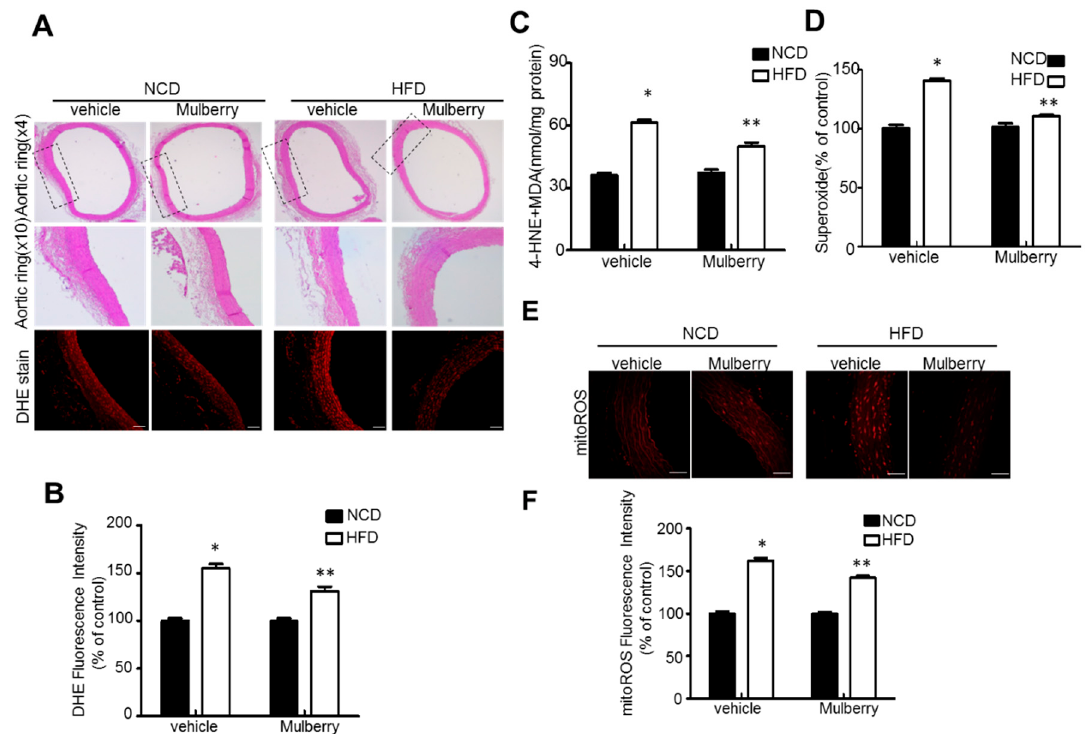
Figure 3. Mulberry inhibits oxidative stress in hyperlipidemic rats. Rats were fed a normal diet or a high-fat diet with or without 100 mg / kg mulberry for six weeks, and serum and aorta rings were harvested. ( A ) Aorta rings tissues retrieved six weeks after initial mulberry administration were subjected to hematoxyline-eosine (H&E) staining and DHE staining. Scale bars, 50 µ m. ( B ) Quantification of fluorescence intensity for superoxide levels in aortas. Values are presented as mean ± SEM ( n = 6, * p < 0.05 versus NCD-group; ** p < 0.05 versus HFD-group). ( C ) MDA plus 4-hydroxynonenal (4HNE) levels in aortic tissues were assessed, respectively. ( D ) Endothelial O 2 − production was assessed as described in the Materials and Methods. ( E ) Representative images of MitoSox staining for mitochondrial superoxide anion production. ( F ) Quantification of fluorescence intensity for mitochondria ROS levels in aortas. Values are presented as mean ± SEM ( n = 6, * p < 0.05 versus NCD-group; ** p < 0.05 versus HFD-group). DHE, dihydroethidium; NCD, normal control